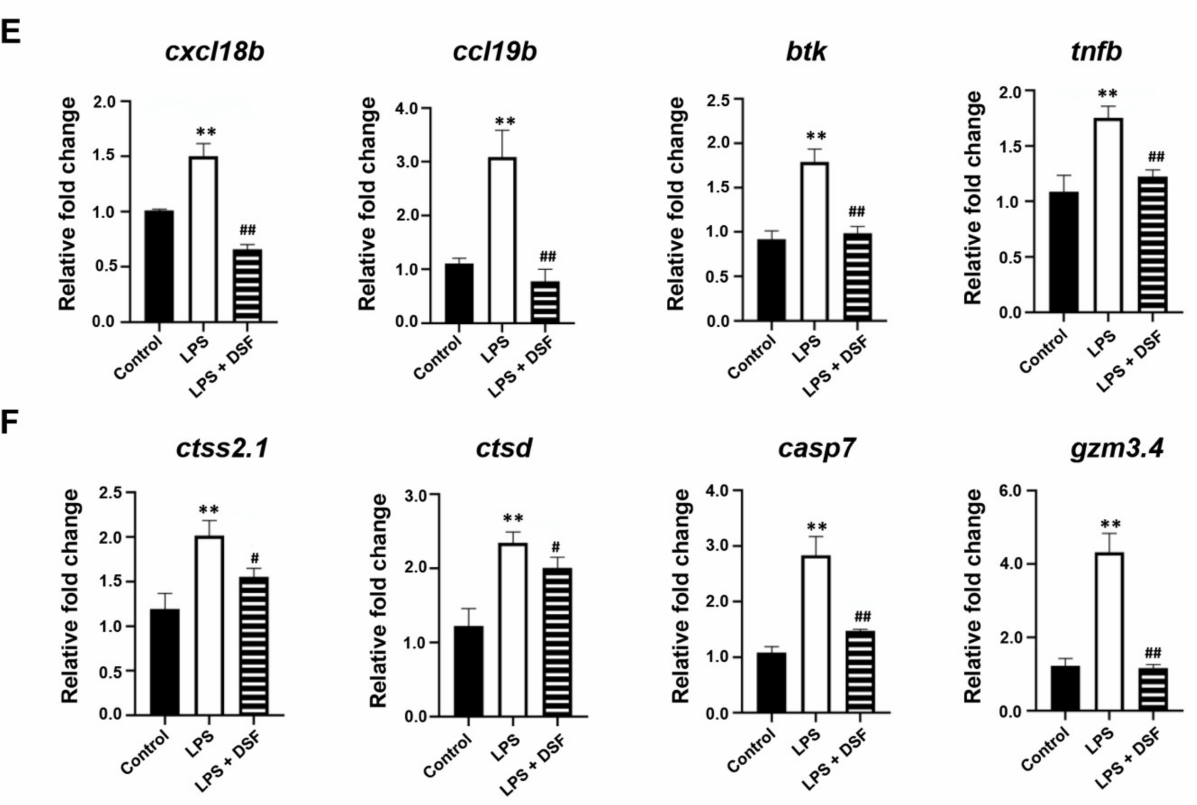
Figure 7. DSF targeting downstream signaling screening and verification. ( A ) Toll-like receptor signaling, ( B ) inflammation cytokines and chemokines, and ( C ) lysosome-apoptosis-related genes ex- plored with heat map analysis and verified with qRT-PCR ( D – F ). Data are represented as mean ± S.D.